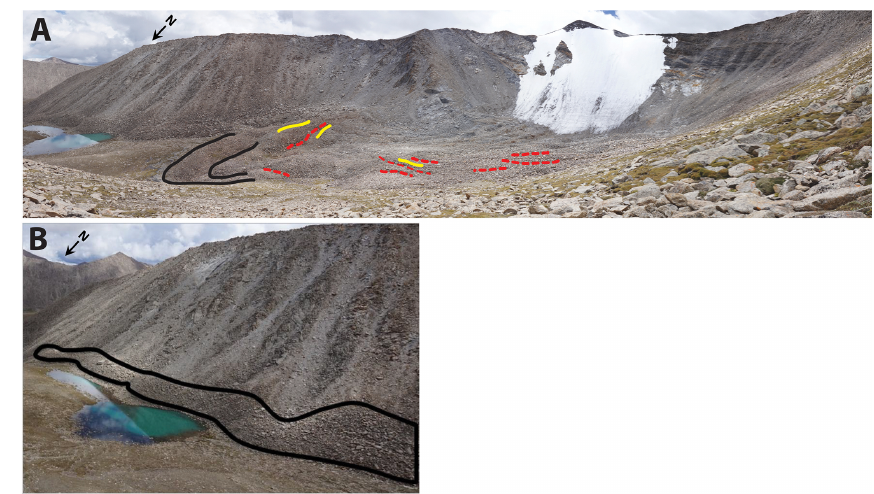
Figure 4. (a) Panorama view on a rock glacier (no. 1) with marked creeping structures (lobe in black, ridges in yellow and furrows in dashed red) in the Qugaqie basin in hanging valley 3. (b) Example of a protalus rampart in hanging valley 3 of the Qugaqie basin. A bulge (in black) formed through creeping of rockfall deposits. The length of the bulge is approximately 500m. The location of the photos can be found in Fig. 6b. (photos: J. Buckel)